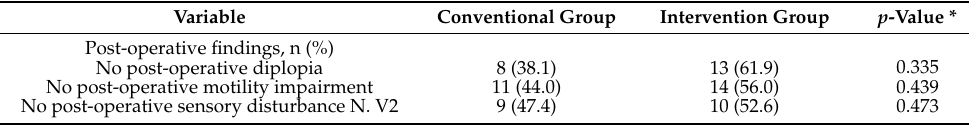
Table 3. Favorable clinical outcome compared between the two